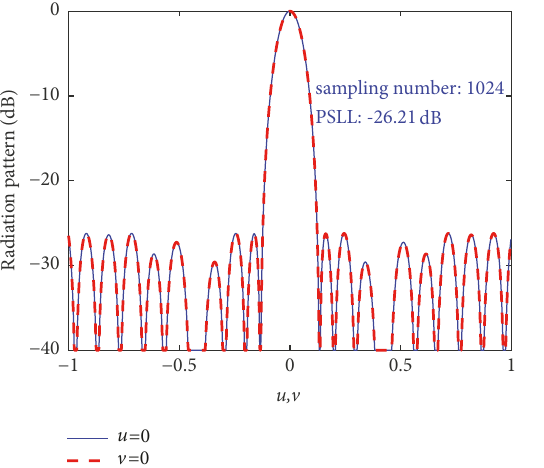
Figure 6: The cut of radiation pattern 𝑢 = 0, V = 0.